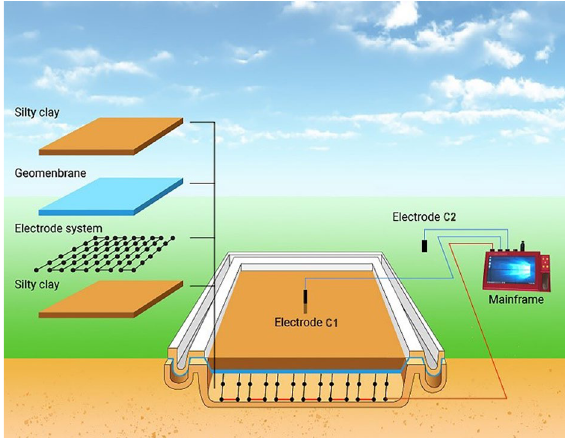
Figure 1. Schematic diagram of parallel potentiometric monitoring